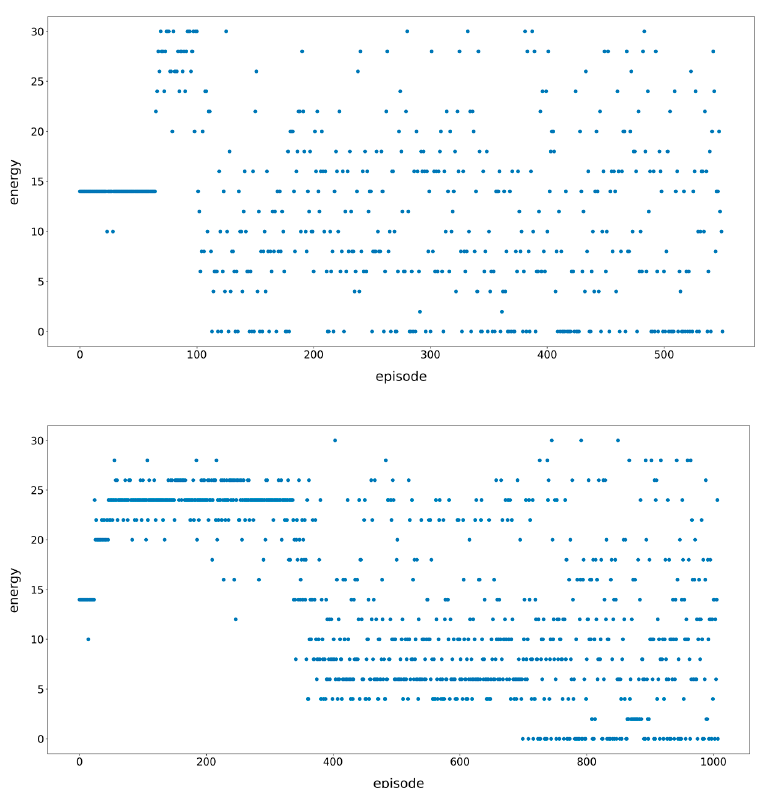
Figure 11. The scatter plot of training results with/without multi-threading accelerating. The picture above is the normal version, and the picture below is the multi-threaded acceleration version. In the figure, the y-axis is the error value between the final state and the native state after each episode, and the x-axis is the number of episodes.